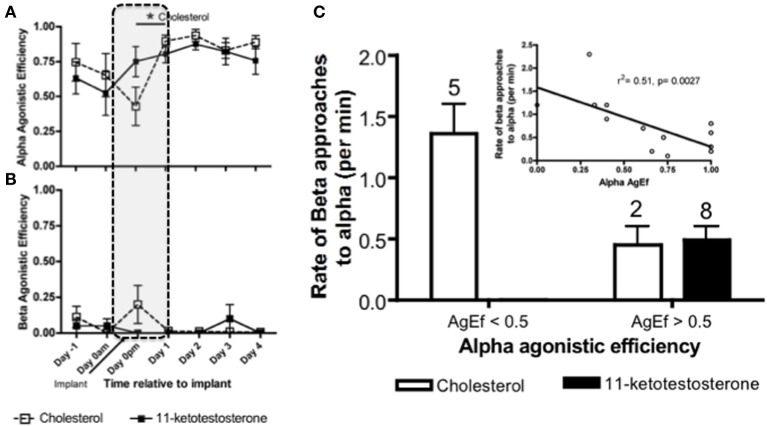
Social context dependent effects of systemic (intraperitoneal) 11-ketotestosterone (KT) implants on agonistic interactions in Lythrypnus dalli. Alpha females were implanted with either KT or cholesterol and placed in a social environment that was permissive for sex change. (A) Alpha agonistic efficiency (AgEf) (displacements/approaches) toward betas relative to time after implant. Alpha females implanted with cholesterol had a decline in agonistic efficiency during the Dominance Phase (represented by dotted lines), but had dramatically higher agonistic efficiency the following day. (B) Beta Agonistic efficiency toward alphas relative to time after implant (n = 8 Chol and n = 10 KT). (C) Categorical representation of rates of beta approaches when alpha agonistic efficiecy was < or > 0.5. The numbers above bars represent the number of groups for each category. The inset is a regression of alpha agonistic efficiecy against rates of betas approaching alphas after alphas were treated with either KT or Cholesterol (N = 15). Note that some individuals were excluded from this analysis due to zero rates of interaction and overlap does not allow all data points to be seen clearly, *p < 0.05.